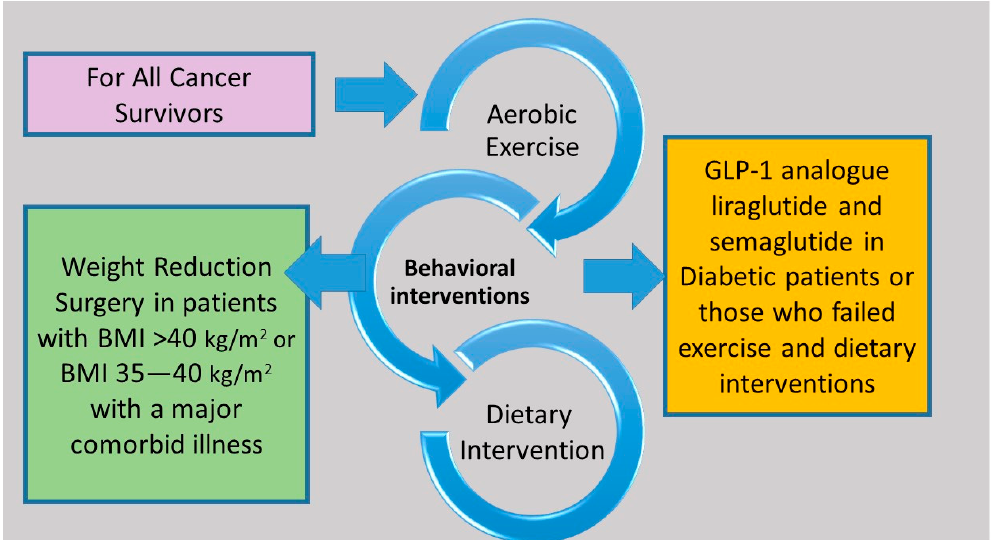
Figure 2. Structured exercise in combination with dietary support and behavior therapy are effective interventions for all cancer survivors. Treatment with glucagon-like peptide-1 analogues and bariatric surgery can be considered in selected cancer survivors.